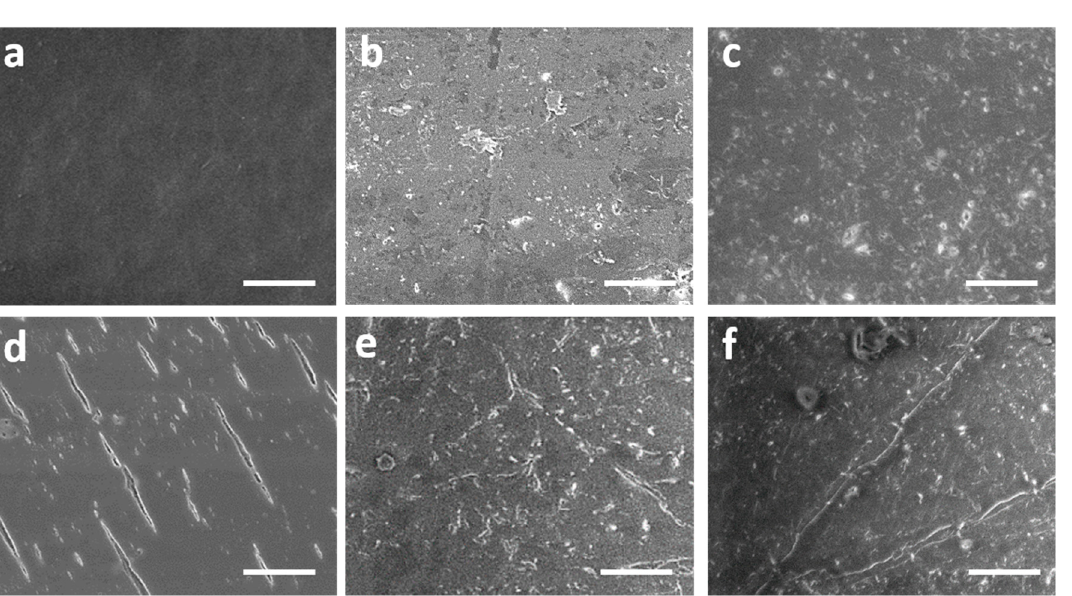
Figure 1. SEM images of the surface of phase change materials (PCMs) before aging—( a ) S1 as a reference, ( b ) S 3 and ( c ) S 7 ; after aging—( d ) S 1 , ( e ) S 3 , and ( f ) S 7. (The bar is equal to 100 µm)